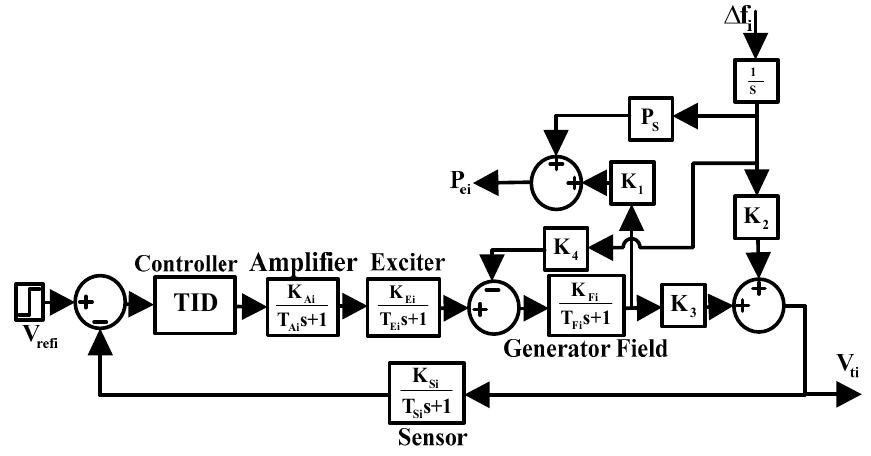
Figure 5. The combined AGC and AVR model.